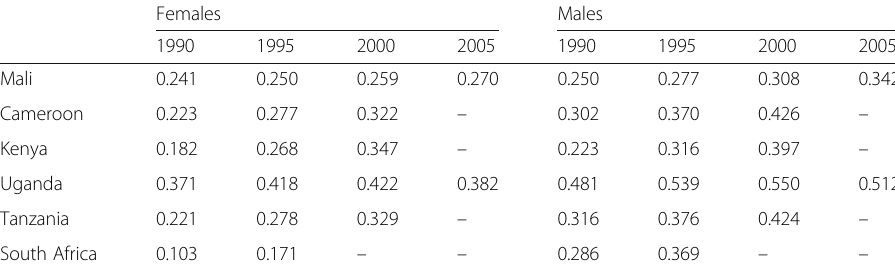
Table 5 Adult mortality estimates derived from sibling histories ( 45 q 15 ) by country and sex